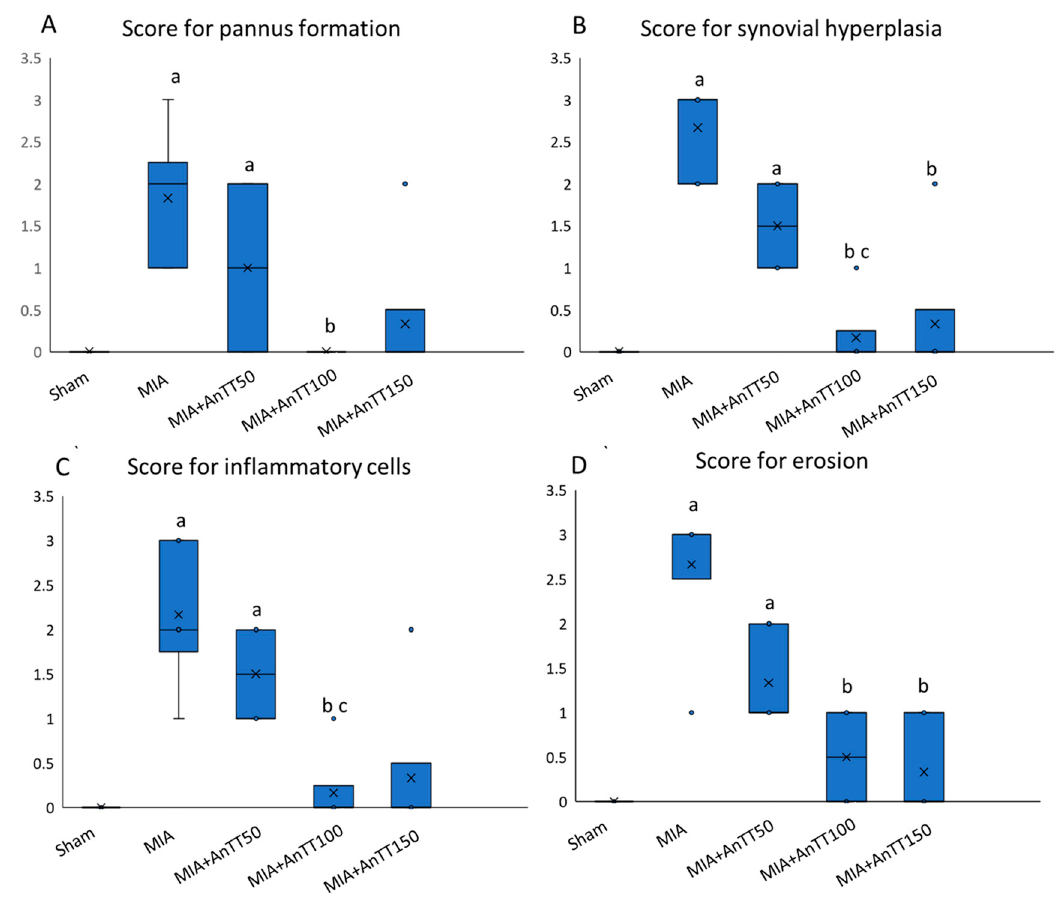
Figure 3. Joint histology score after treatment; the score for pannus formation ( A ); synovial hyperplasia ( B ); inflammatory cells ( C ); erosion ( D ). The data are shown as mean with standard error of the mean. The letter ‘a’ indicates a significant difference versus the sham group; ‘b’ versus the MIA group; ‘c’ versus the AnTT50 group. Abbreviation: AnTT, annatto tocotrienol. The symbol ‘x’ in the box plot represents the mean value, ‘ ∘ ’ represents the outliers, while the horizontal line in the box represents the median of the group.